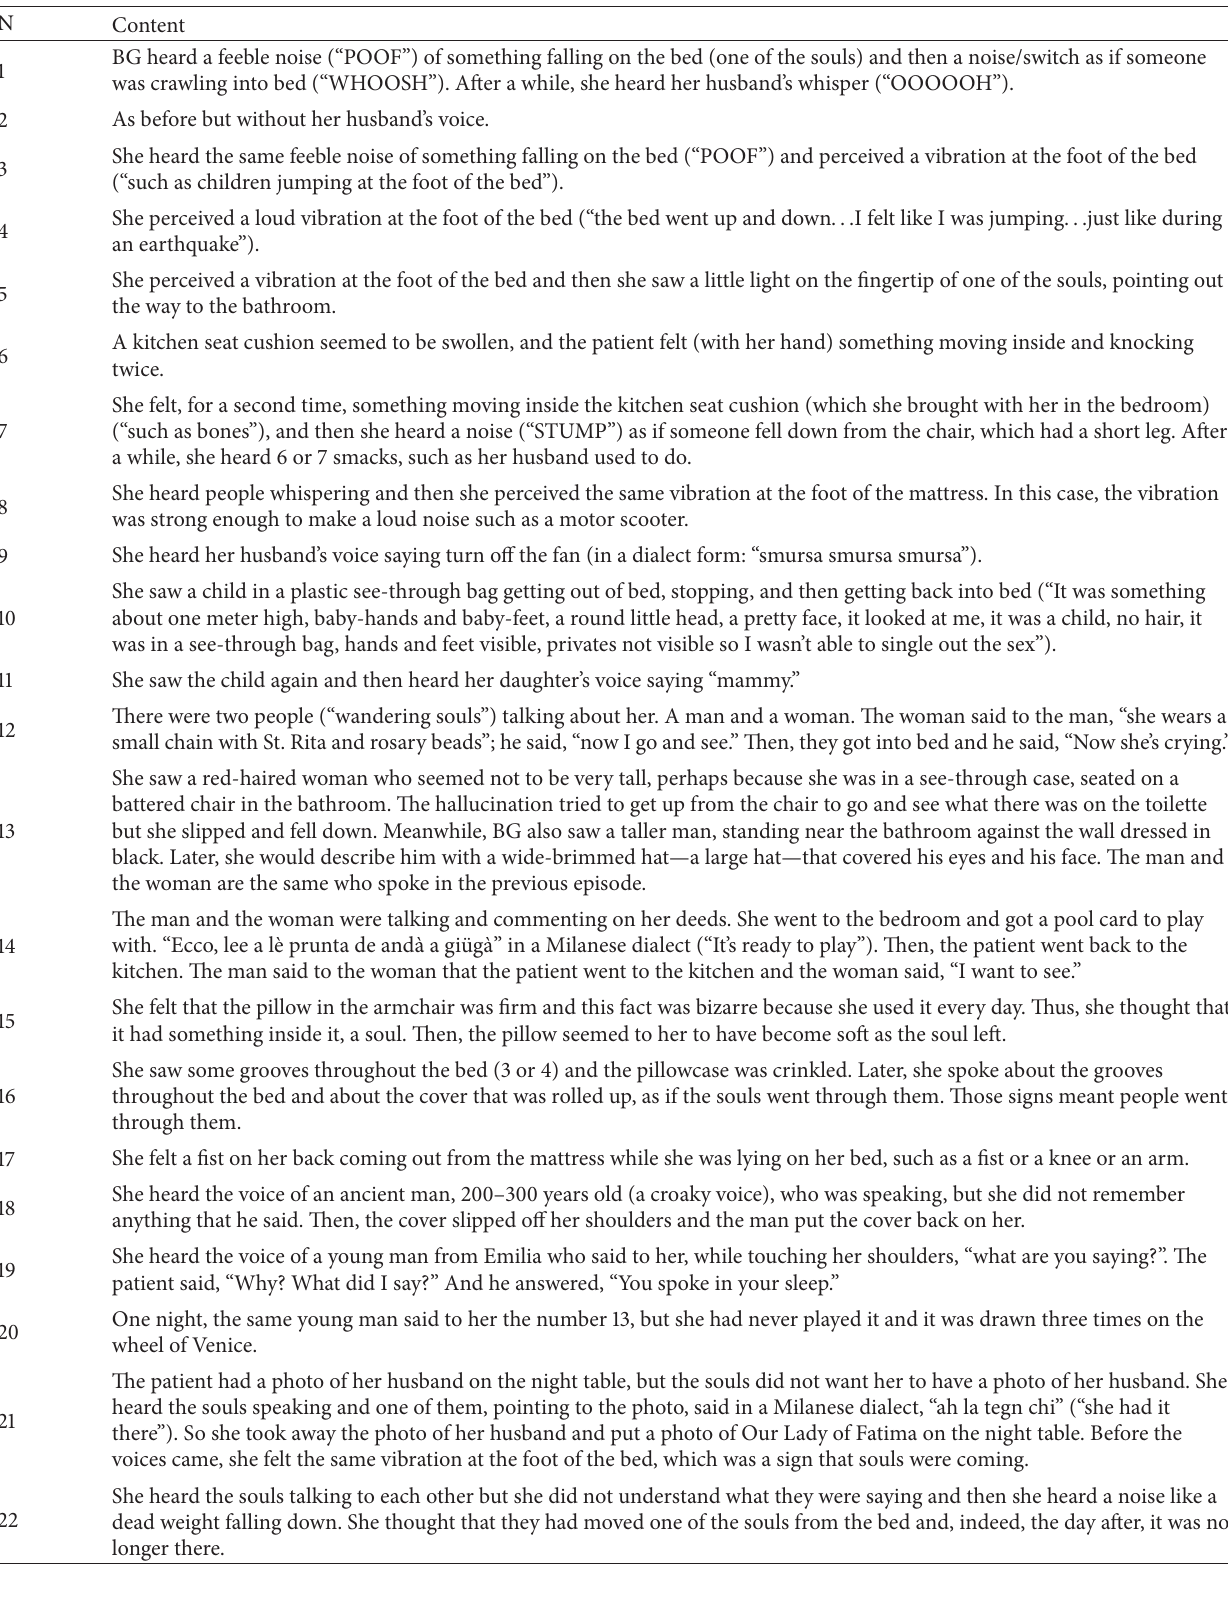
Table 2: Content of BG’s